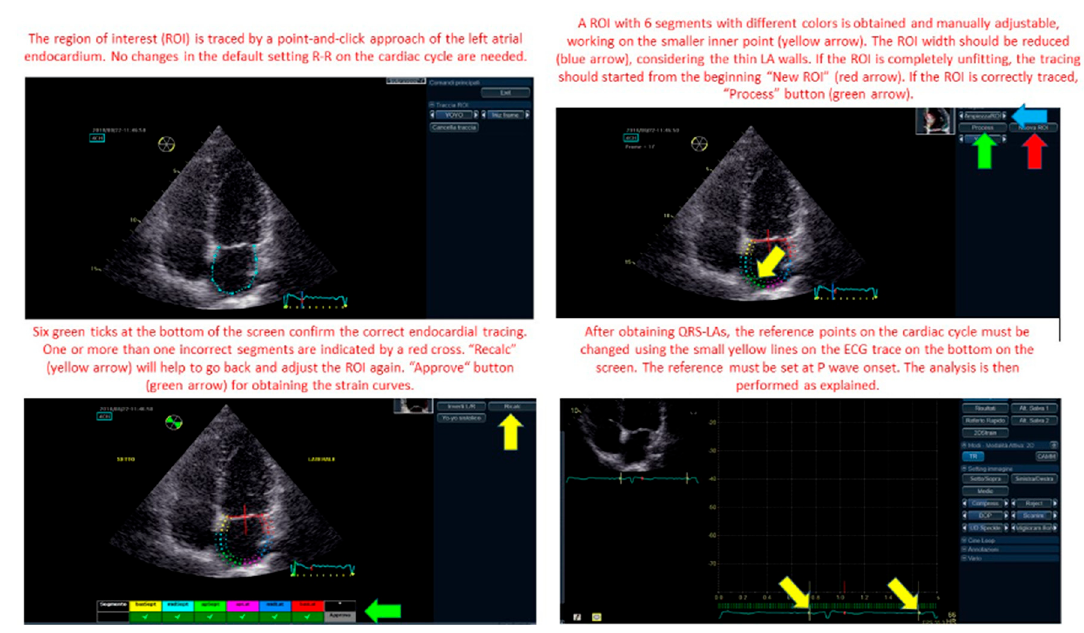
Figure 1. Left atrial (LA_ strain region of interest (ROI) tracing and modification. Zero reference point for LA strain analysis changing from QRS to P wave.